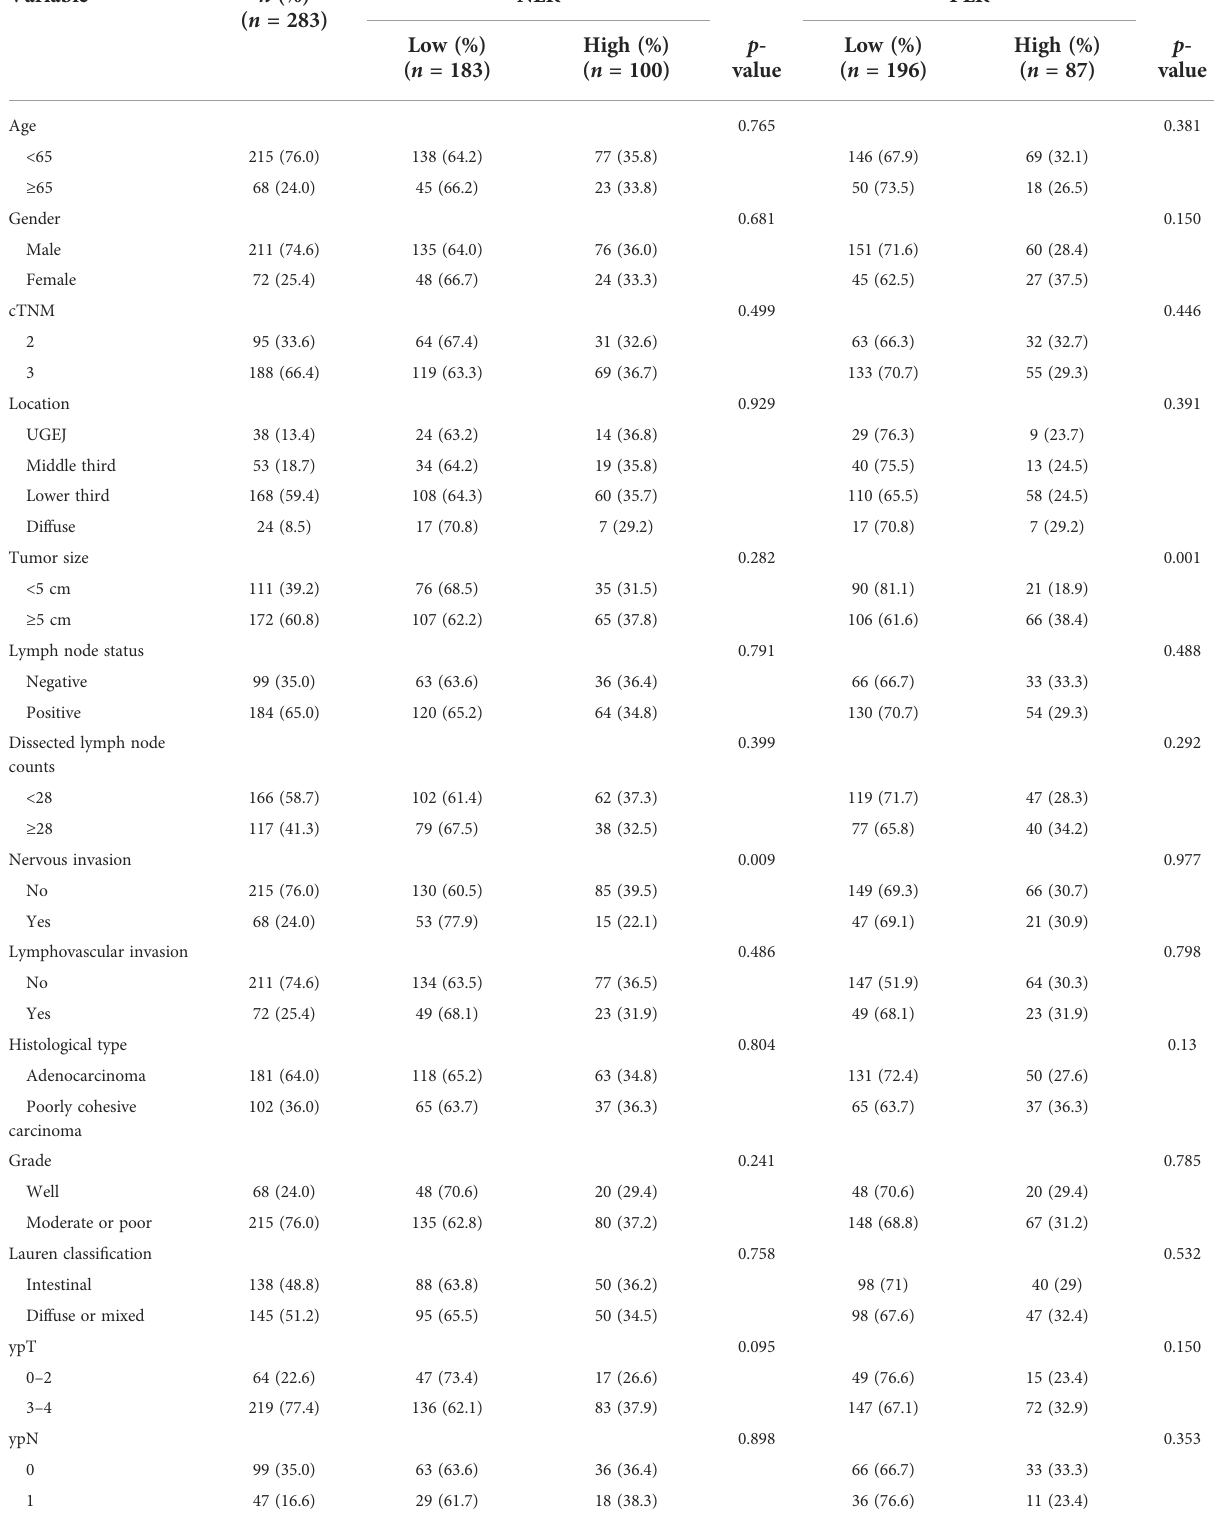
TABLE 2 Association of baseline characteristics to NLR or